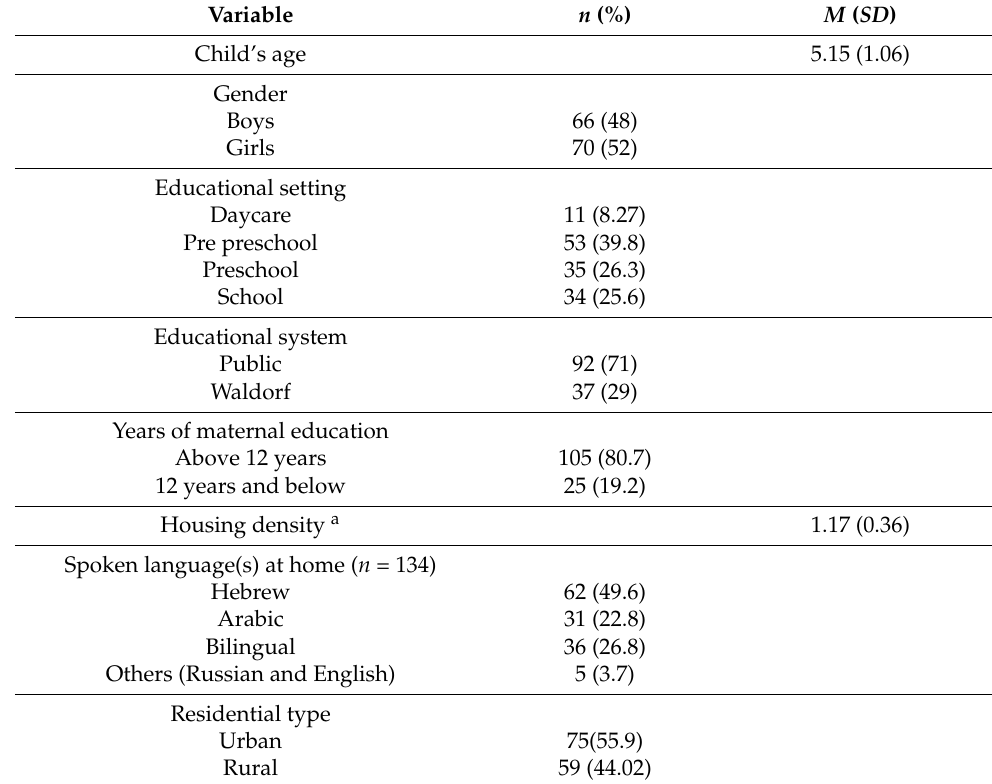
Table 1. Socio-demographic characteristics of the sample ( n =